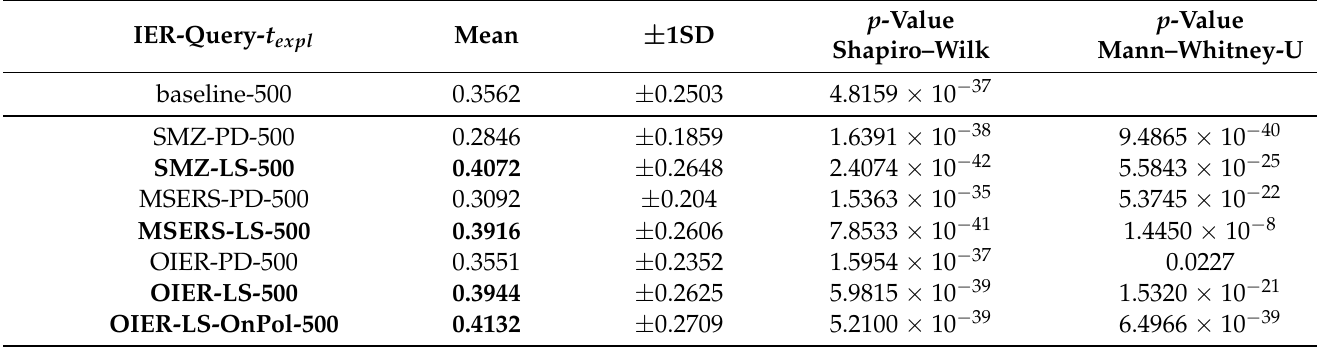
Table A3. A summary of the results of experiment 3 with state-encoding LKE. Bold mean entries show a better perfor- mance in comparison to the corresponding baseline; bold IER-Query- t expl entries indicate statistically significant superior performance compared to the